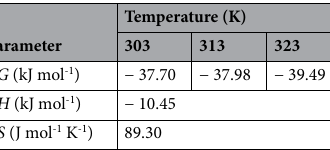
Table 3. Thermodynamics parameters of MB adsorption onto N g